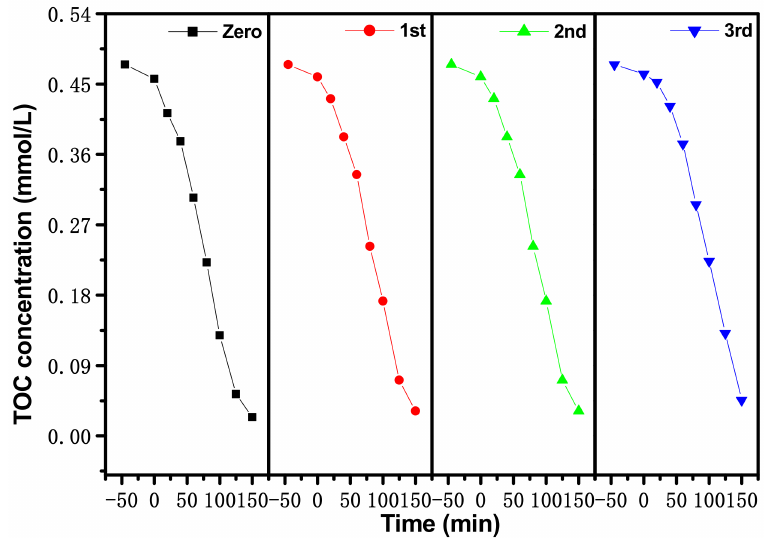
Figure 15. Consistence change curves of TOC during PCD of ENR within pharmaceutical waste water with EBH as photocatalyzer under VLGI for three recursion retrogradation